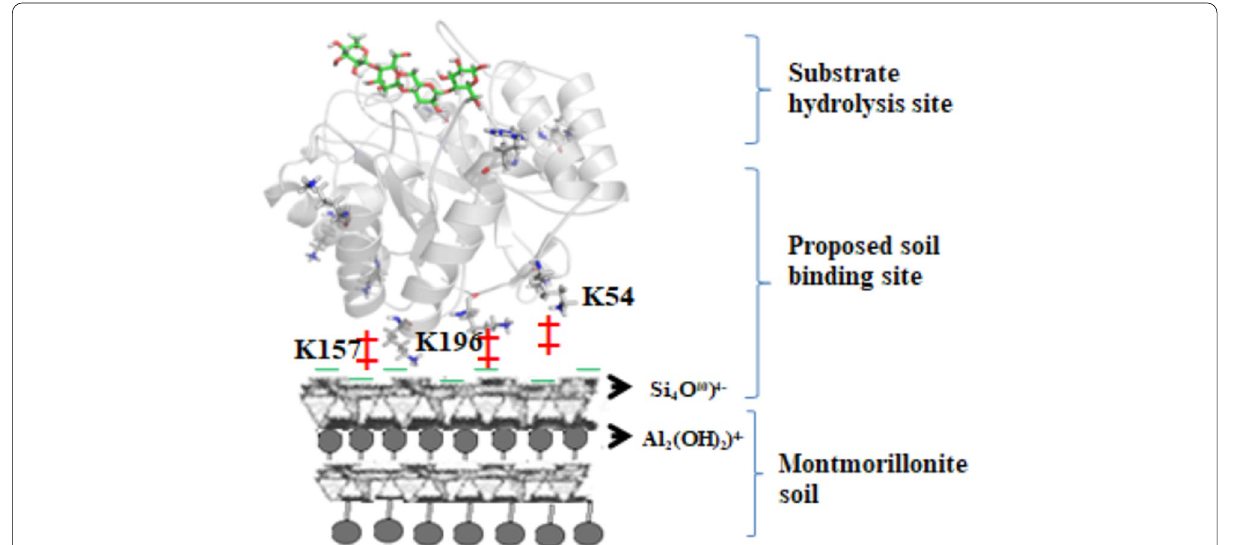
Fig. 5 Model of proposed protein-clay mineral-substrate complex, depicting binding of Cel5H protein with surface positive amino acids on clay mineral